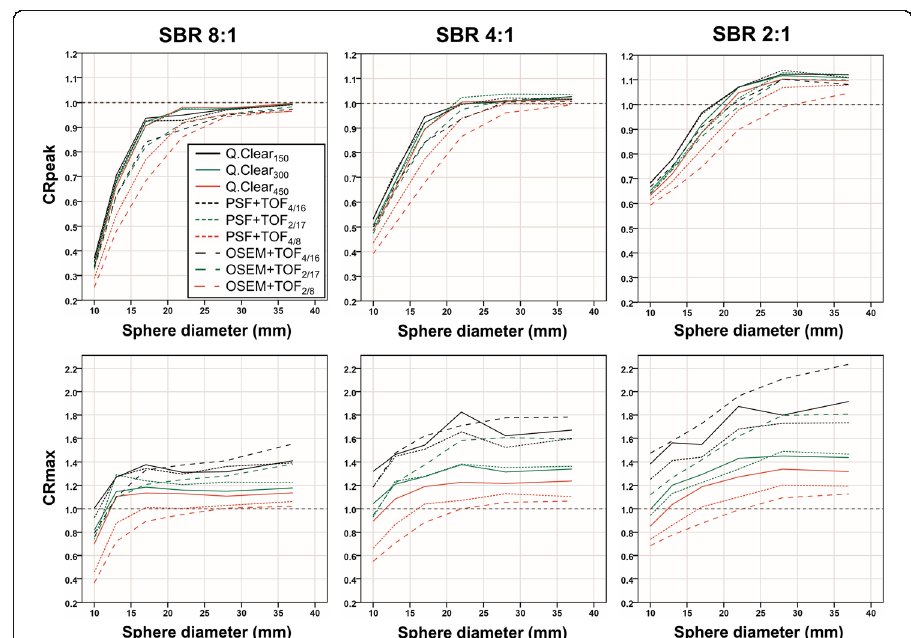
Fig. 4 CRpeak and CRmax. Peak contrast recovery (CRpeak; upper row) and maximum contrast recovery (CRmax; lower row) are displayed for all reconstruction algorithms at the three signal-to-background ratios (SBR) as a function of sphere